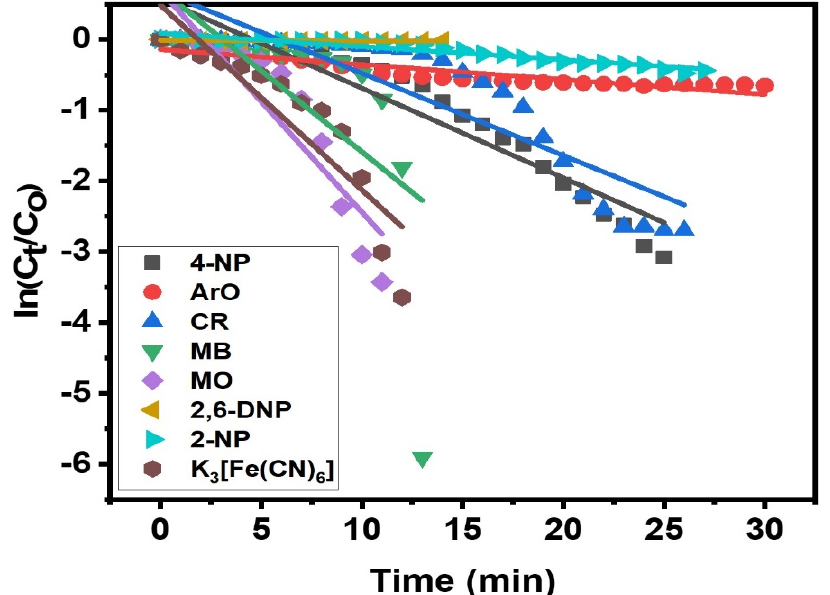
Figure 4. Kinetic study for reduction of 4-NP (0.13 mM), ArO (0.07 mM), CR (0.07 mM), MO (0.07 mM), MB (0.07 mM), 2,6-DNP (0.13 mM), 2-NP (0.13 mM), and K 3 [Fe(CN) 6 ] (0.5 mM) using 0.5 mL NaBH 4 (0.1 M) and Cu@Alg/Co–CeO 2 catalyst (4